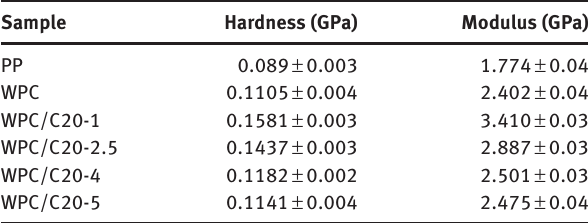
Table 2: Hardness and modulus values of PP, WPC and WPC with C20 nanoclay loading.